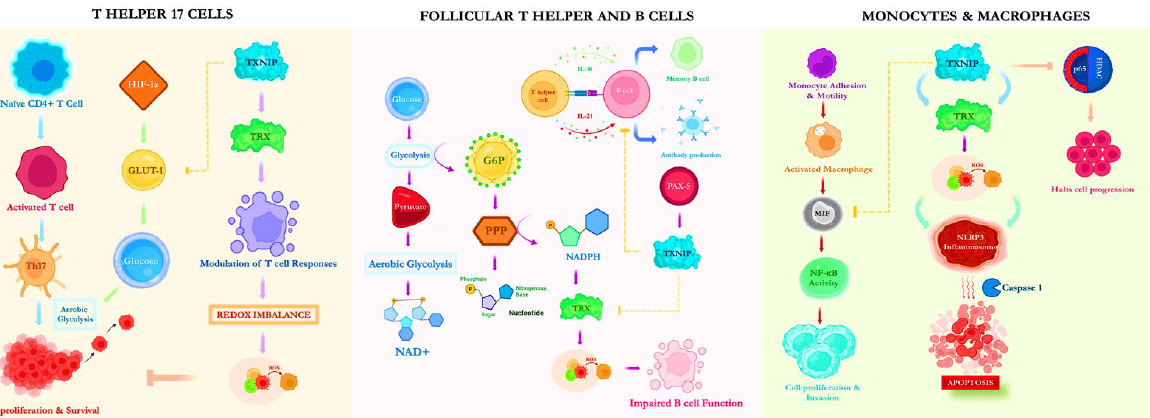
Figure 1. Mechanistic actions of TXNIP on different immune cells drive cancer impediments.